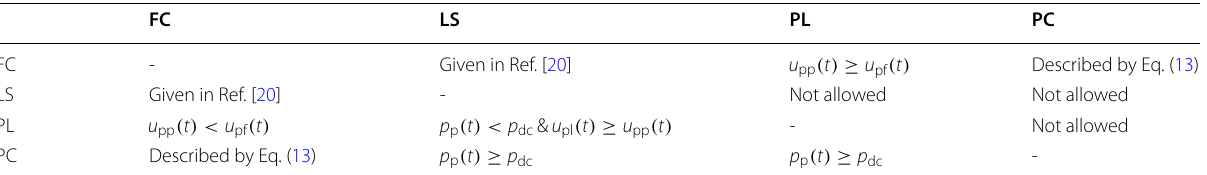
Table 1 Switching rule of the controller